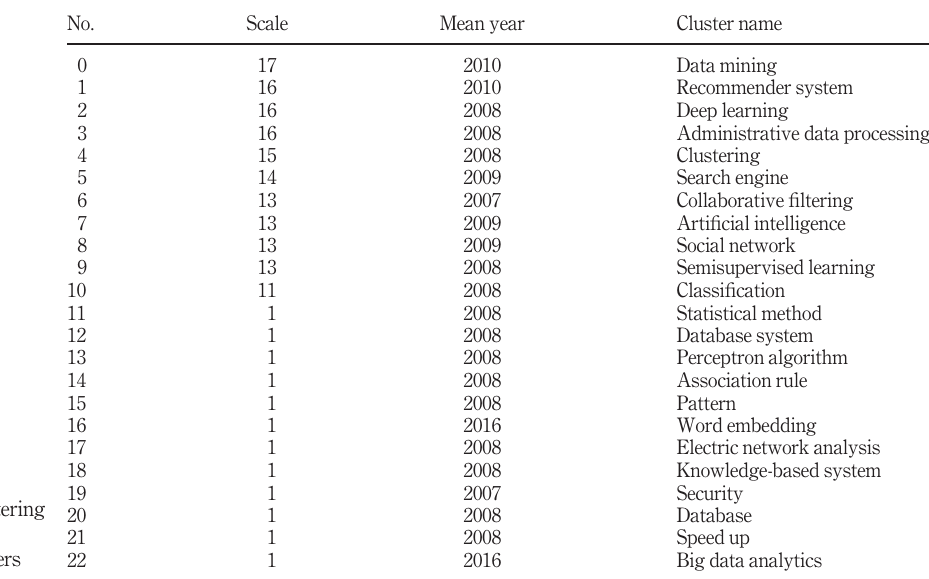
Table 4. Keywords clustering statistics of conference